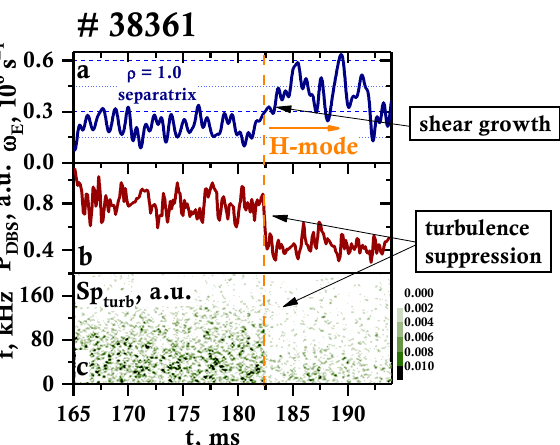
Figure 6. Temporalevolutionof: ( a )velocityshear, ( b )DBSamplitude, and( c )DBSamplitudespectrogram. Figure 6. Temporal evolution of: ( a ) velocity shear, ( b ) DBS amplitude, and ( c ) DBS amplitude spec- trogram.